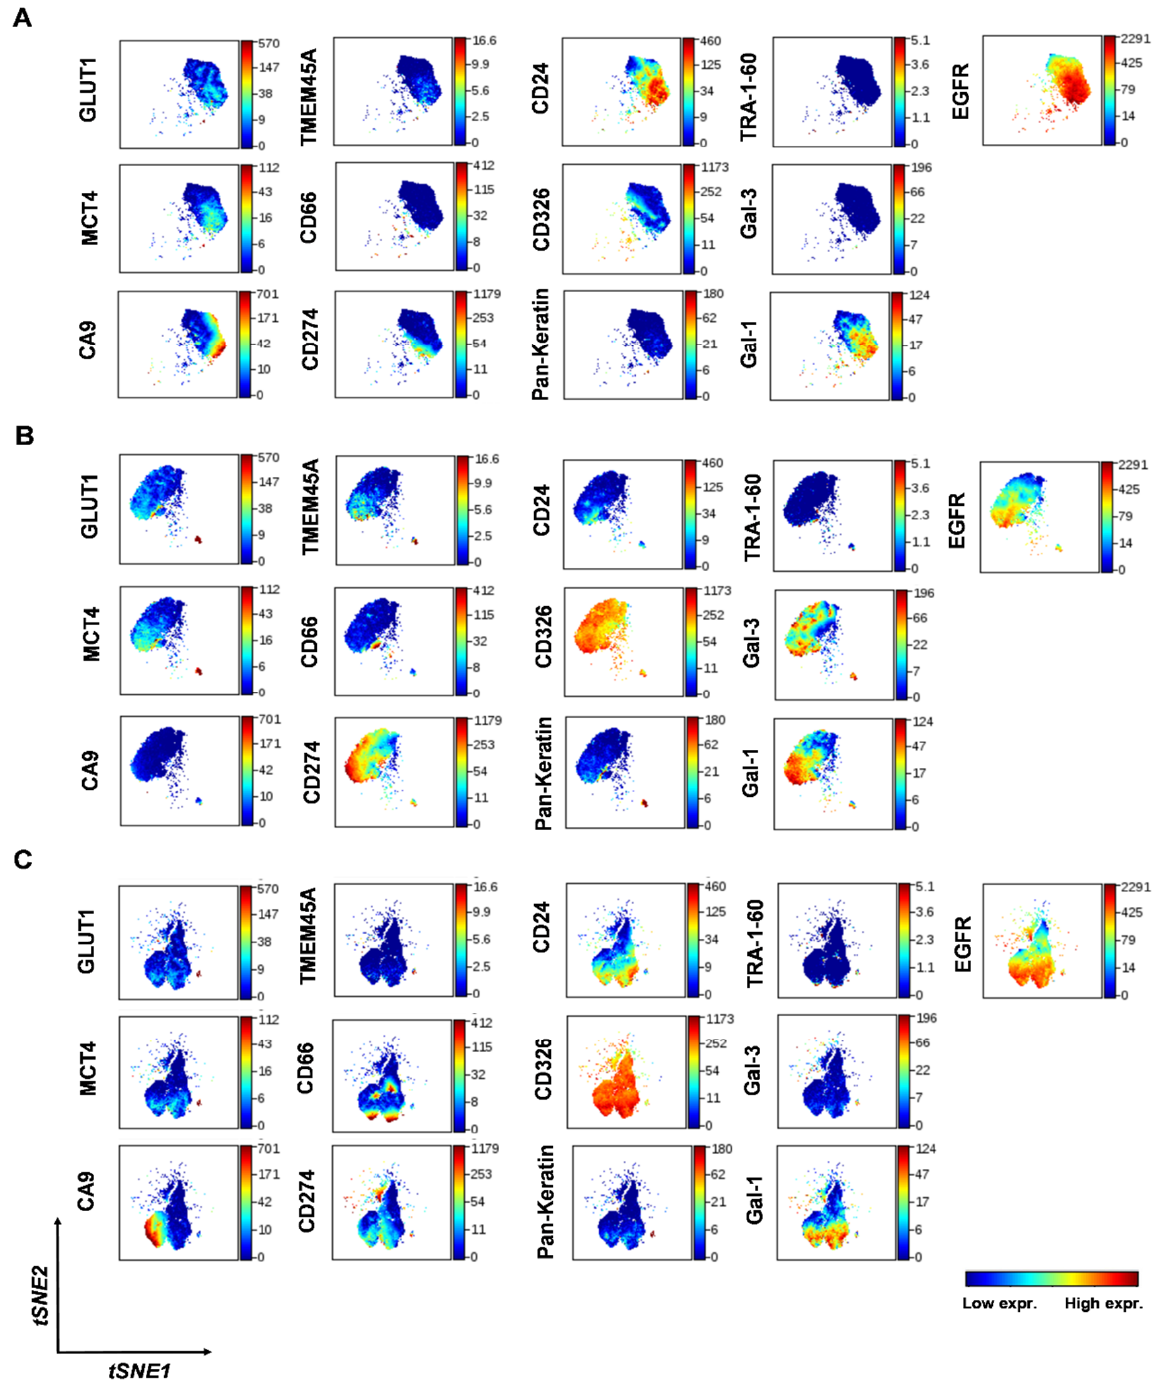
Figure 2. Single-cell heterogeneity of the human NSCLC cell lines. Representative multidimensional visualization of t-distributed stochastic neighbor embedding (viSNE) analysis of 13 protein markers at single-cell resolution in ( A ) A549, ( B ) H1975, and ( C ) H1650 cells. The analysis was performed within 10 5 cells (iterations = 2000, perplexity = 30, theta = 0.5).